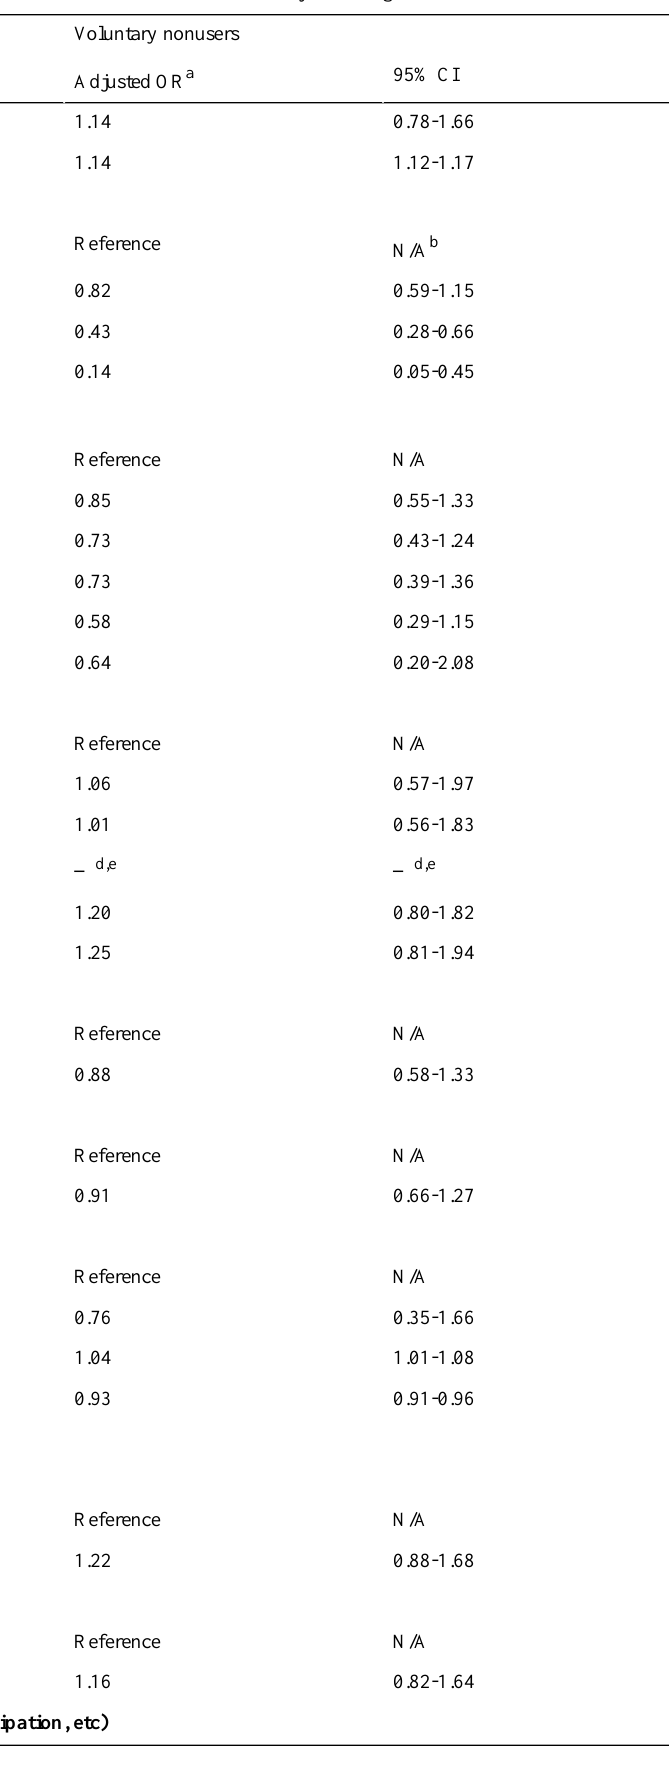
Table 3. Multiple logistic regression results examining the factors associated with the act of voluntarily not using the